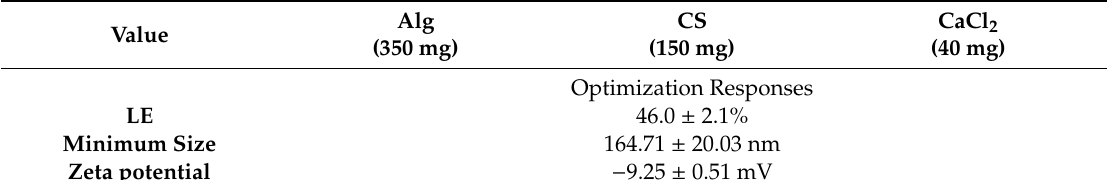
Table 5. Response optimization plot for di ff erent responses.